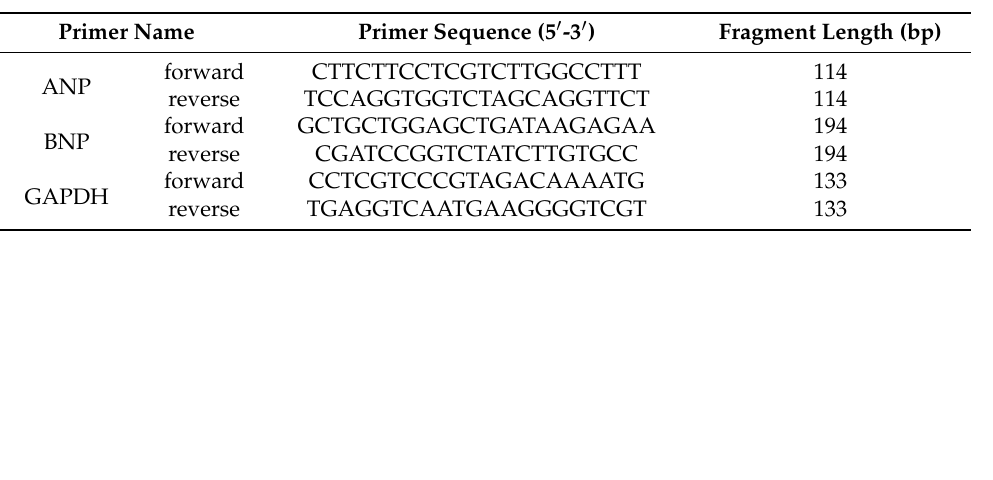
Table 1. Primer sequences for hypertrophy